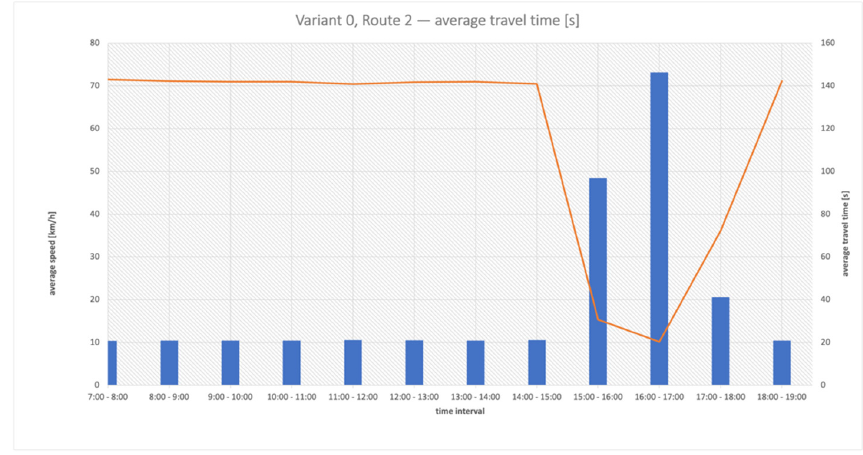
Figure 4. Variant 0; Section 1—average travel time [s].